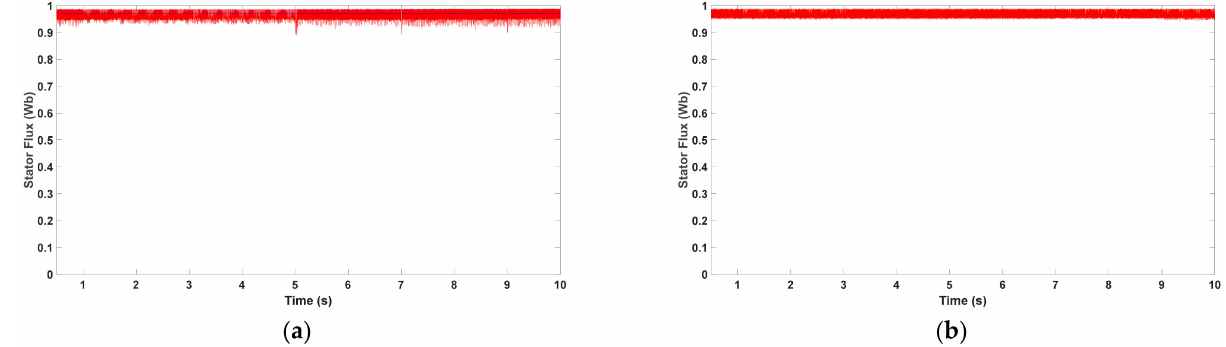
Figure 16. Stator flux response with ( a ) 6-sectors and ( b ) 12-sectors DTC control strategies.